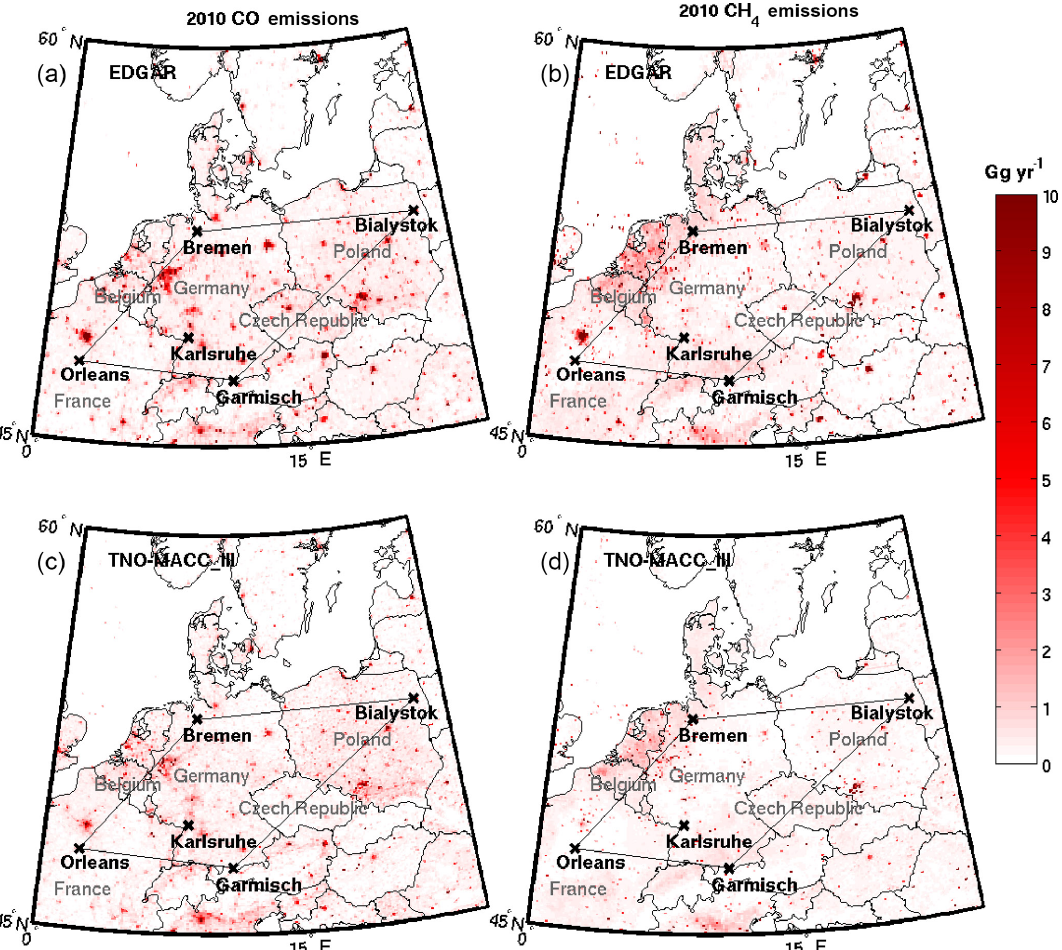
Figure A3. These maps show the inventory emissions for the year 2010 in the study area (delineated by the solid straight lines) and the surrounding region. The TCCON stations are marked with black “x” symbols and labeled in black bold font. The countries intersected by, or contained within, the study area are labeled in grey. The map in (a) shows the EDGAR v4.3.1 emissions inventory for carbon monoxide. The map in (b) shows the EDGAR FT2010 emissions inventory for methane. The map in (c) shows the TNO-MACC_III emissions inventory for carbon monoxide. The map in (d) shows the TNO-MACC_III emissions inventory for